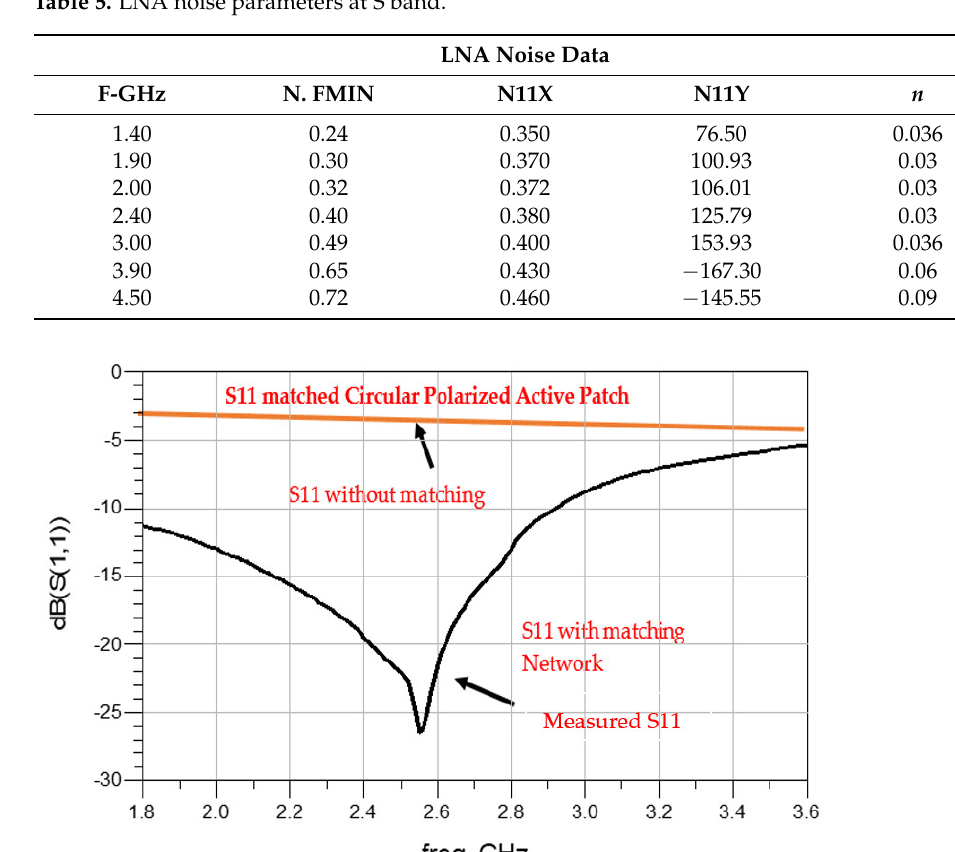
Figure 10. Measured S11 of the Circular polarized active receiving antenna.